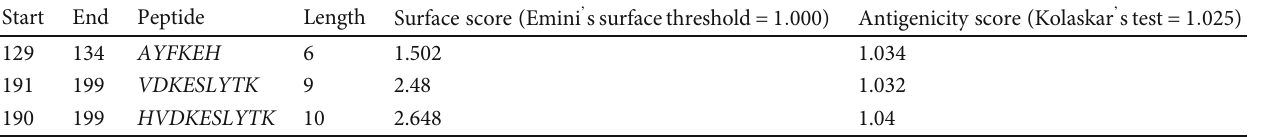
Table 2: List of the most promising B-cell epitopes and their surface and antigenicity.